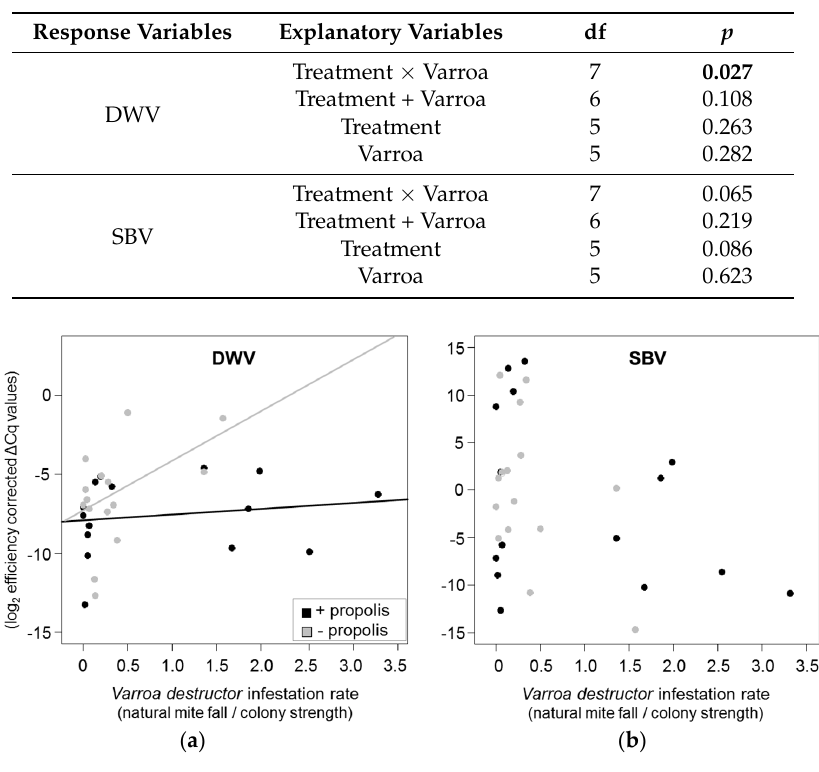
Figure 2. ( a , b ) Effect of the high (black) and low propolis (grey) treatment on the correlation between viral loads and the V. destructor mite infestations of ( a ) deformed wing virus (DWV); and ( b ) sacbrood virus (SBV). Each dot represents data from one colony for one month. Virus titers and V. destructor infestation were measured for each colony once per month from July to September 2013. Lines represent linear regressions between DWV virus titers (log 2 efficiency corrected fold-change relative to housekeeping gene, Cq = quantification cycles) and V. destructor infestation rates (natural mite fall/colony strength) for each treatment group according to significant interaction between treatment and V. destructor infestation (see Table Table 2. Results of different mixed-effects models testing for effects of high and low propolis treatment (“Treatment”) and V. destructor infestation (“Varroa”) with (Treatment × Varroa) and without (Treatment + Varroa) interactions included (=explanatory variables) on titers of the deformed wing virus (DWV) and the sacbrood virus (SBV) (=response variables) over three months (number of samples N = 30, three repeats per colony). In all models, colony and month were included as random factors to take into account colony-specific differences and repeatedly measuring the same colony. Table shows degrees of freedom (df) and p-values ( p ) for comparing all models presented against the null model (i.e., a model including only colony and sampling date as random factors). Significant p -value is marked in bold. Response Variables